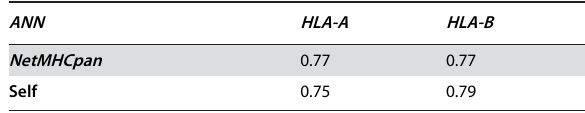
The average performance per locus of the pan-specific NetMHCpanA and –panB predictors vs. single allele specific ANN’s trained using only data from available self-HLA molecules. Training and validation is done in a conventional cross- validated manner as described in Materials and methods with added